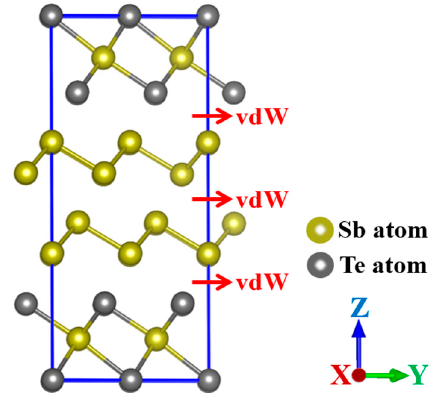
Figure 8. Schematic diagram of Sb 2 Te lattice. The space group of Sb 2 Te is P − 3 m 1. There are van der Waals bonds along the c-axis. Sb atom is colored by brown and Te atom is marked by grey. Table 3 gives the structural parameters of 200 nm and 1000 nm Sb 2 Te thin